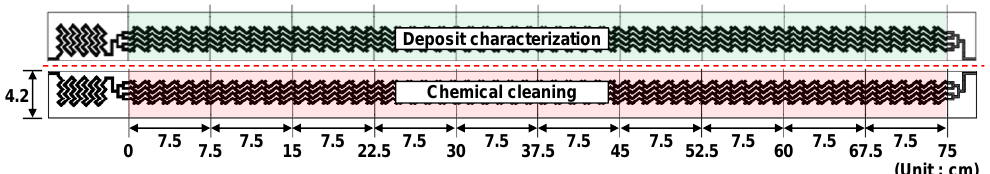
Figure 3. Drawing for sectioning the PCHE.